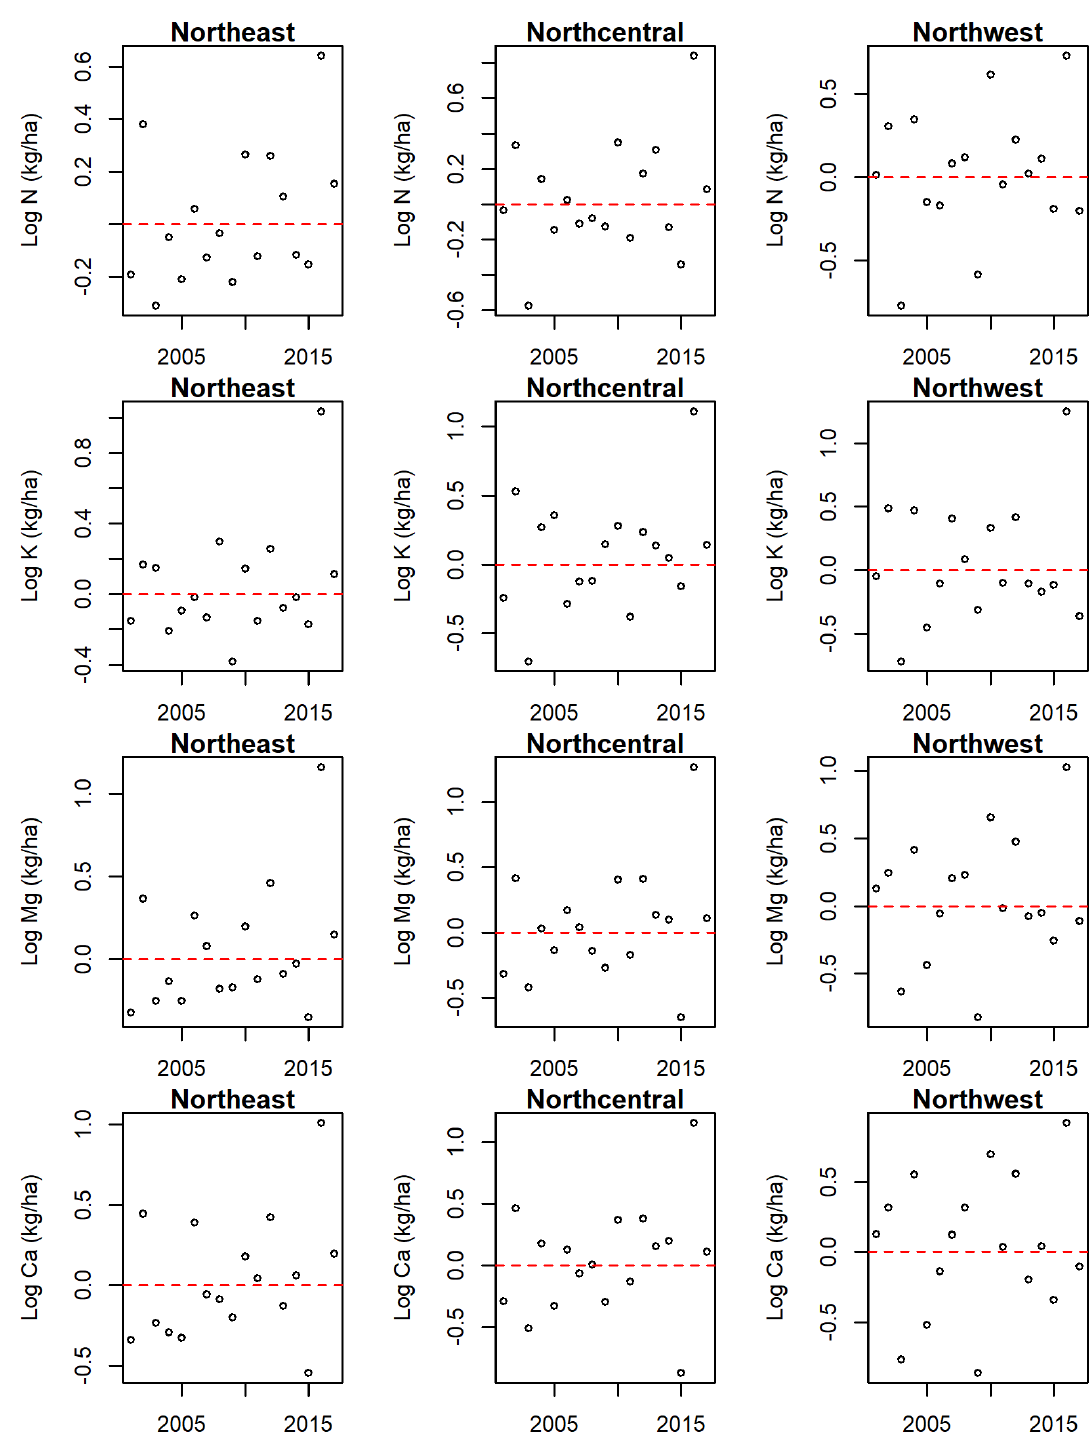
Figure A2. Time series of total atmospheric deposition time series for regional harvest model inputs after differencing and log transformation. When excluding the large spike in the 2017 deposition, seen as the second from right value due to differencing, the processes appear to generally be detrended or white-noise.